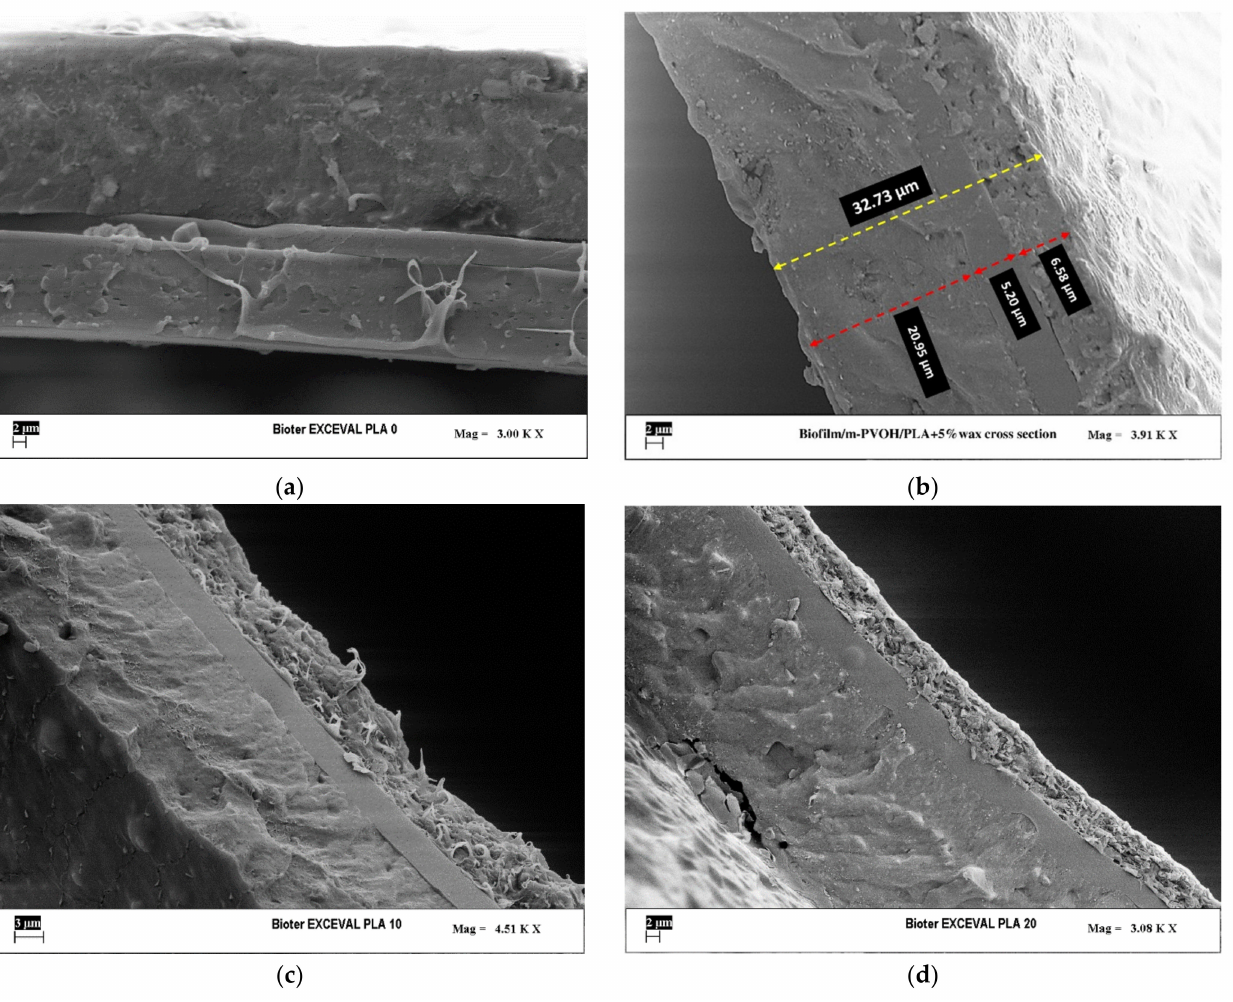
Figure 6. Cross-sectional SEM micrographs, respectively, of: Biofilm/m-PVOH/PLA + 0% wax ( a ), Biofilm/m-PVOH/PLA + 5% wax ( b ), Biofilm/m-PVOH/PLA + 10% wax ( c ), Biofilm/m- PVOH/PLA + 20% wax ( d )